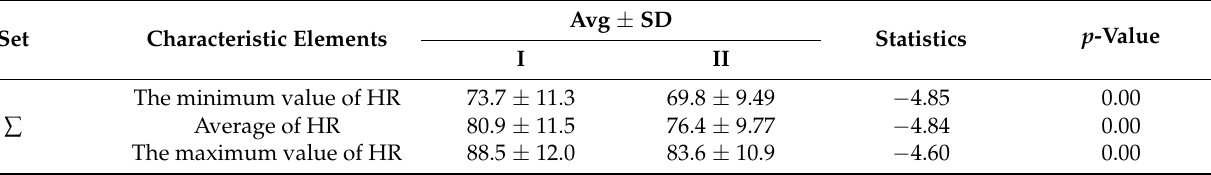
Table 5. Three characteristic elements with high